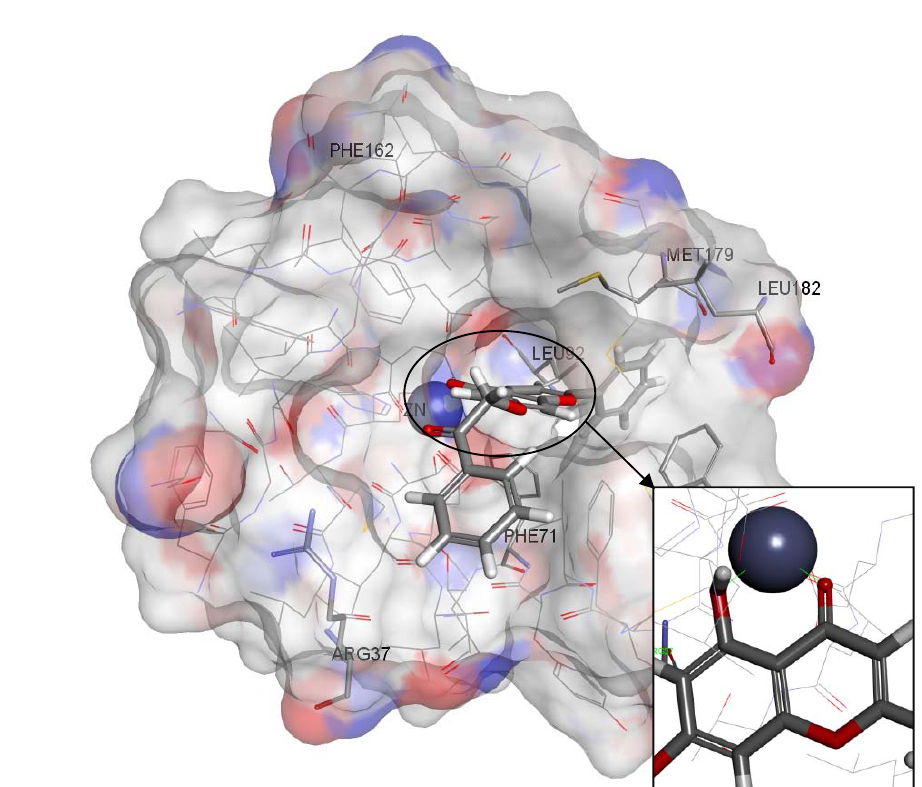
Figure 10. Zinc05528245 docked inside the Glo-1 active